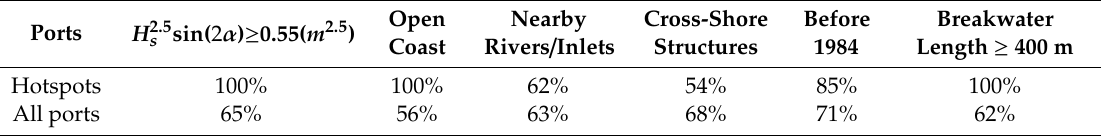
Table 6. The probability of occurrence of coastline evolution drivers for the hotspots compared to all other ports in the Pan-African Seaports